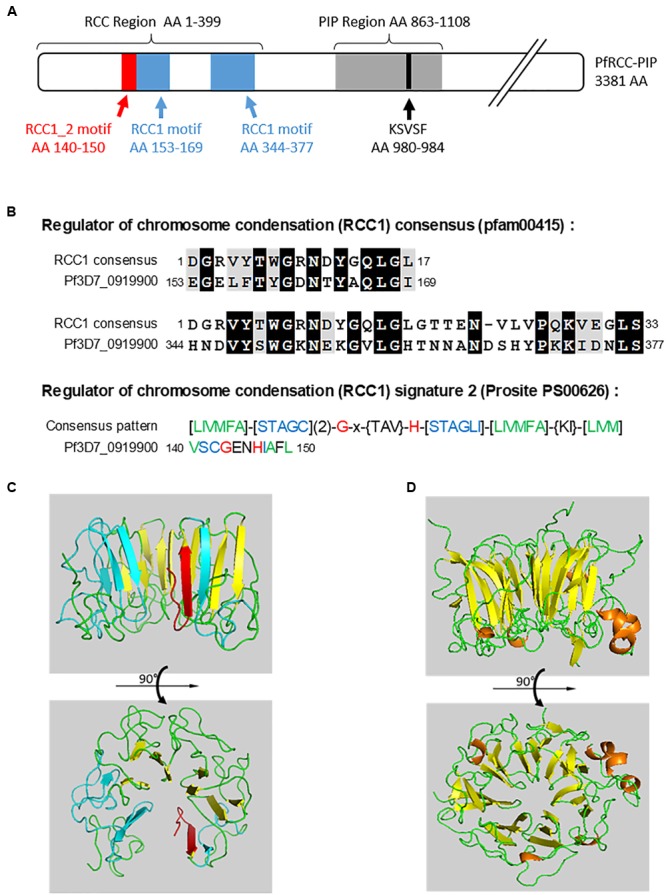
Sequence analysis of PfRCC-PIP. (A) Schematic representation of PfRCC-PIP. The RCC and PIP regions with the RVXF motif (in black), two RCC1 (in blue), and one RCC1_2 (in red) motifs are indicated. The portion of PfRCC-PIP detected by Y2H is highlighted in gray. (B) Alignments of the two RCC1 motifs of PfRCC-PIP with RCC1 consensus motif (pfam00415) and RCC1_2 of PfRCC-PIP with RCC1 signature 2 consensus motif (Prosite PS00626). (C) Predicted model of the portion of PfRCC-PIP containing the RCC1 motifs (AA 140–424), based on the structure of human RCC1 (D) (BAA00469.1) (see text footnote 1). Beta sheets are represented by arrows, RCC1 motifs are colored in blue and RCC1_2 motif in red.